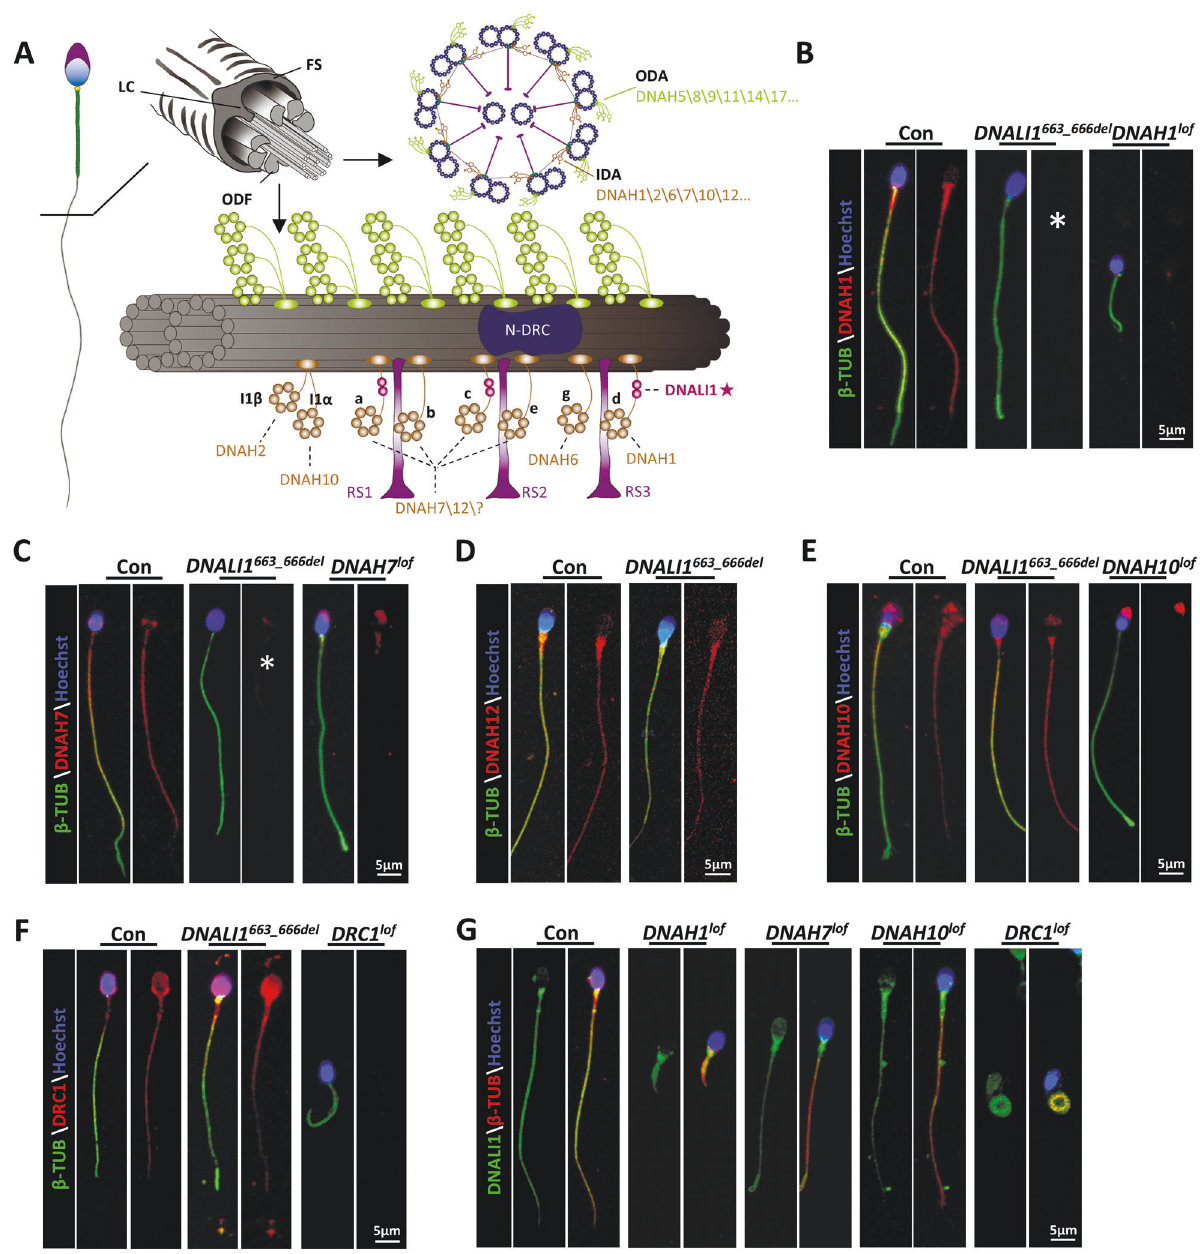
Fig. 2 Location of IDA components in the human fl agellum. A A schematic diagram of the positions of the dynein proteins docks on the A-tubule of the microtubule doublet (green) in the 96 nm axonemal repeat, according to the prior structural information on Chlamydomonas and Sea urchin sperm fl agella. B – E IF illustrating various dyneins components ’ locations on the human sperm fl agella. A loss of DNALI1 leads to the mislocation of DNAH1( B ) and DNAH7( C ). Asterisks indicate the miss of DNAH1 and DNAH7, respectively. F IF staining against DRC1 (a component of the N-DRC structure adjacent to IDA). G The spermatozoa from male infertile patients with indicated protein de fi ciency are stained with